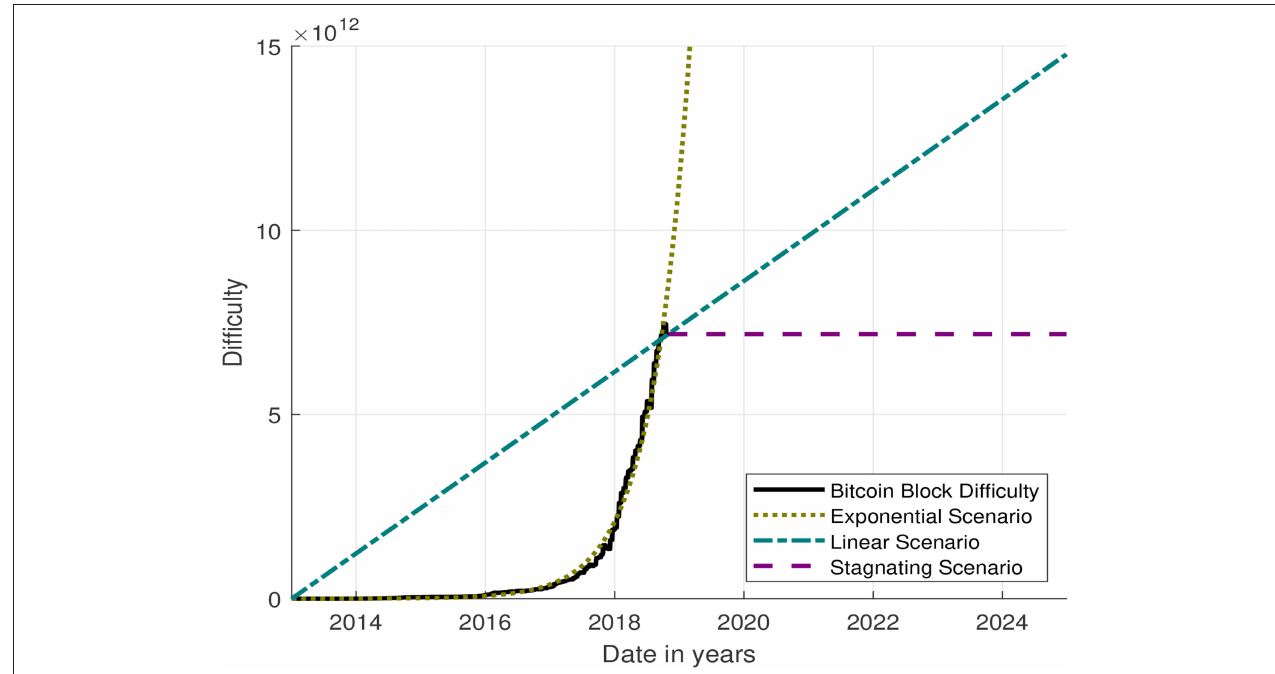
FIGURE 2 | Exponential, linear, and stagnating scenario for the future development of the Bitcoin block difficulty fitted to the past difficulty. Data for the Bitcoin block difficulty from Blockchain Luxembourg S.A. (2018).